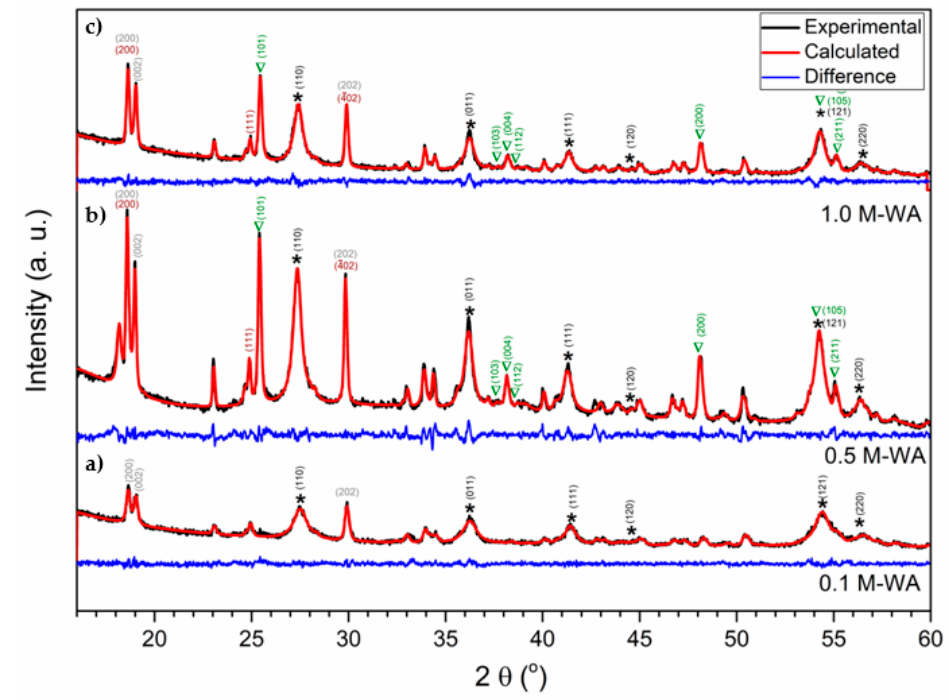
Figure 4. XRPD patterns of ( a ) 0.1 M-WA powder; ( b ) 0.5 M-WA powder; and ( c ) 1.0 M-WA powder, obtained with oxalic acid solutions at 155 °C and 50 bar. Unmarked peaks: ferrous oxalate hydrated. Main crystalline planes of ferrous oxalate hydrate (PDF 72-1305, a = 12.06 Å) indexed in brown and those of ferrous oxalate hydrate (PDF 23-0293, a = 9.84 Å) in gray. Marked peaks: rutile (*), PDF #21-1276 and anatase ( ∇ ), PDF #21-1272. Calculated patterns (in red) were obtained through Le Bail adjustment.